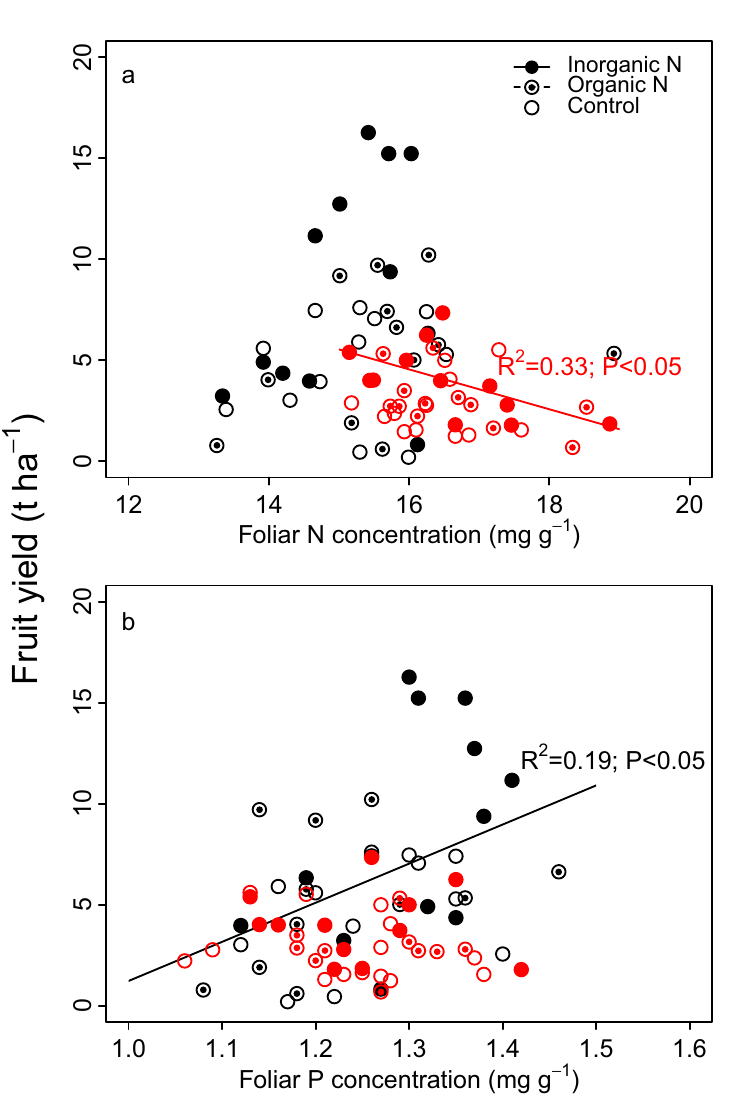
Fig 5. Relationships between lowbush blueberry foliar chemistry and fruit yield (t ha -1 ). (a) Relationship between N concentrations (mg g -1 ) and fruit yield; (b) Relationship between P concentrations (mg g -1 ) and fruit yield. Results are shown for plots of C . peregrina (red symbols) and D . spicata (black symbols) subjected to the three fertilization treatments (inorganic N, organic N, and control). (red symbols) were associated with a higher weed aboveground biomass and a higher blue- berry aboveground vegetative biomass (AGVBM) as well as higher foliar N concentrations. By contrast, plots with D . spicata (black symbols) were associated with higher blueberry fruit yields, foliar Ca concentration, and individual fruit mass.